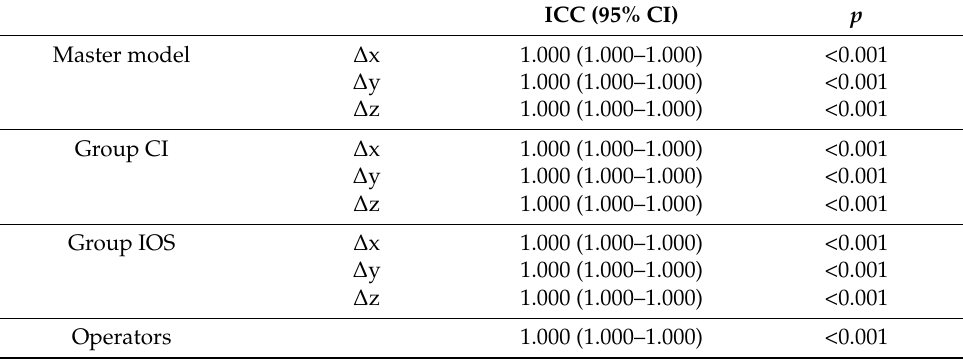
Table 1. Reliability test using intraclass correlation coefficient